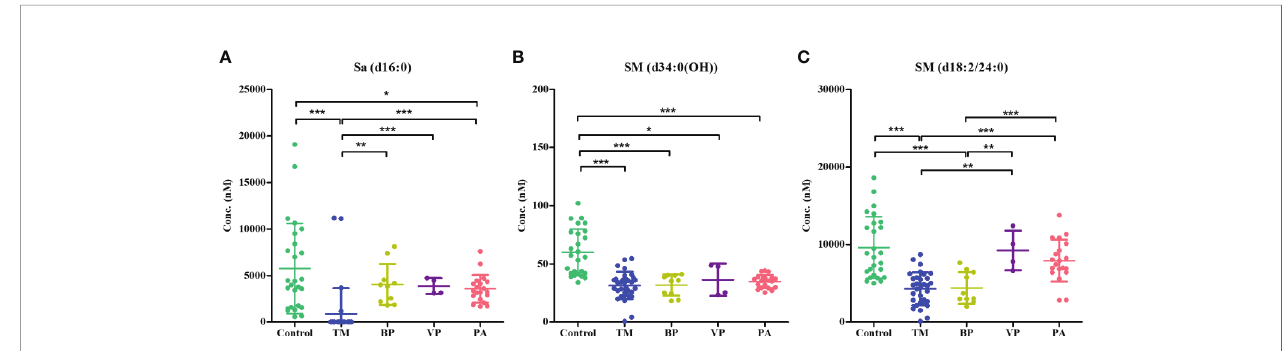
FIGURE 5 | Scatter plots showing the serum levels of (A) Sa (d16:0), (B) SM [d34:0(OH)], and (C) SM (d18:2/24:0) within the control group ( n = 26), the TM group ( n = 32), the BP group ( n = 10), the VP group ( n = 4), and the PA group. Horizontal lines indicate the mean ± SD (* P < 0.05, ** P < 0.01, *** P < 0.001).